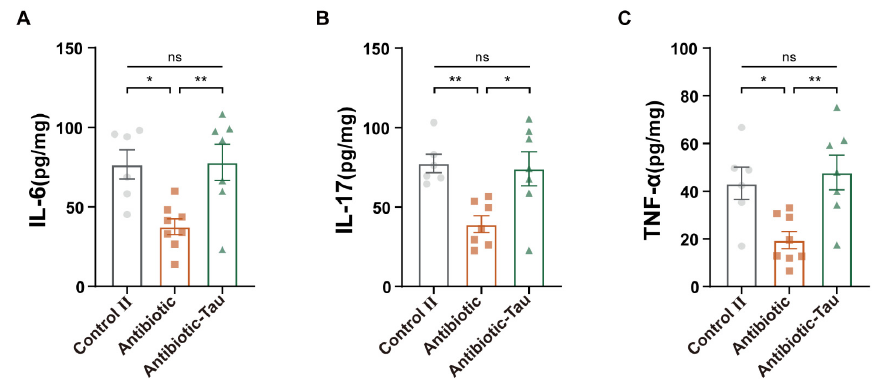
Figure 6. Effect of taurine on cytokines in antibiotic-treated mice. ( A ) IL-6, ( B ) IL-17, and ( C ) TNF- α . Results are presented as the means ± SEM (n = 6–8). * p < 0.05, ** p < 0.01, and p > 0.05 = not significant (ns), by one-way ANOVA followed by Tukey’s